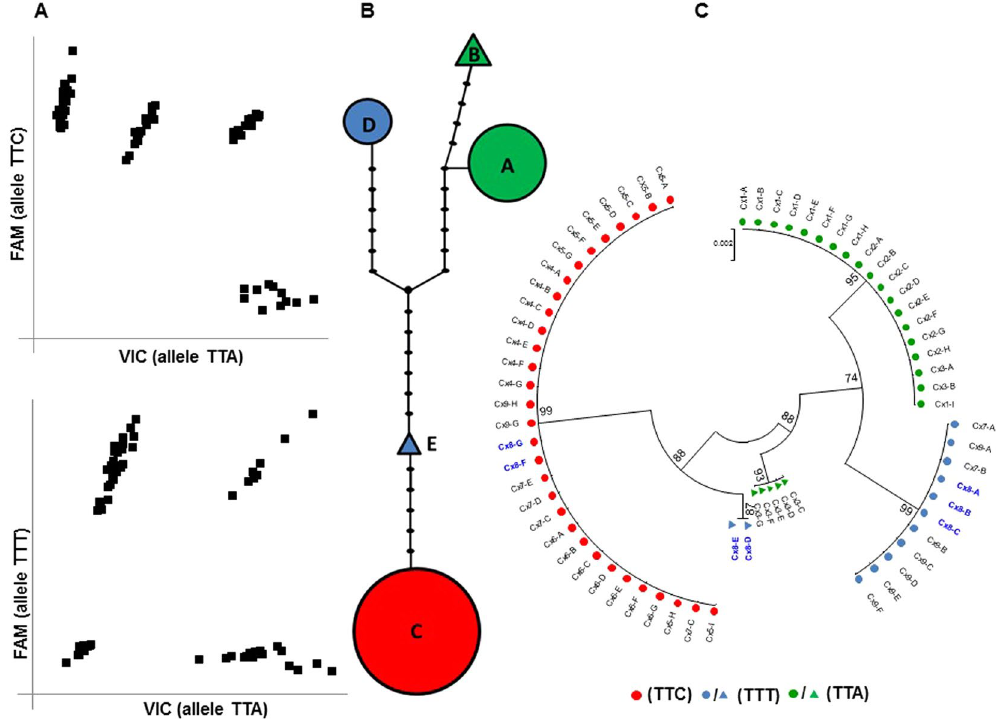
Figure 1. Haplotype diversity based on partial sequence of the Vgsc gene from Ugandan C . quinquefasciatus ( A ) Scatter plot of TaqMan-based allelic discrimination for TTA/TTC and TTA/TTT (where TTC and TTT represent alternative codons for the 1014F mutation). ( B ) Haplotype network of a 677 bp fragment of the Vgsc gene encompassing the 1014 codon. Polygon sizes denote the relative number of samples represented by each haplotype. The branches between black dots represent mutational steps separating observed haplotypes. ( C ) Dendrogram of individuals with a likely duplication of the Vgsc gene. (Cx number) represents an individual sample identifier and the letters A to I correspond to distinct colonies sequenced per sample. Individual Cx8 is highlighted in blue since this mosquito displayed ≥ two haplotypes. Green, red and orange shapes correspond to distinct Vgsc- 1014 alleles.